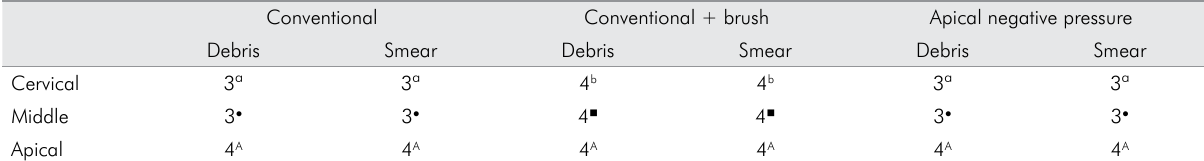
Table 3. Median values for the removal of debris and smear layer using various irrigation/aspiration protocols, considering each root canal